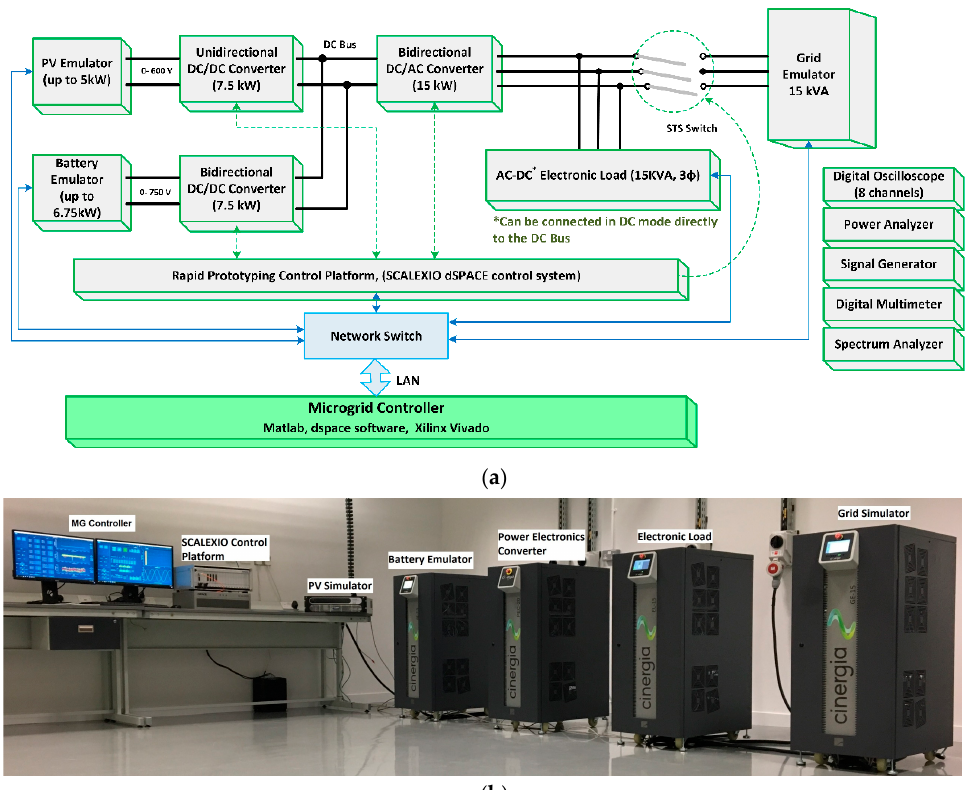
Figure 11. Experimental microgrid verification setup: ( a ) layout block diagram, ( b ) physical setup.